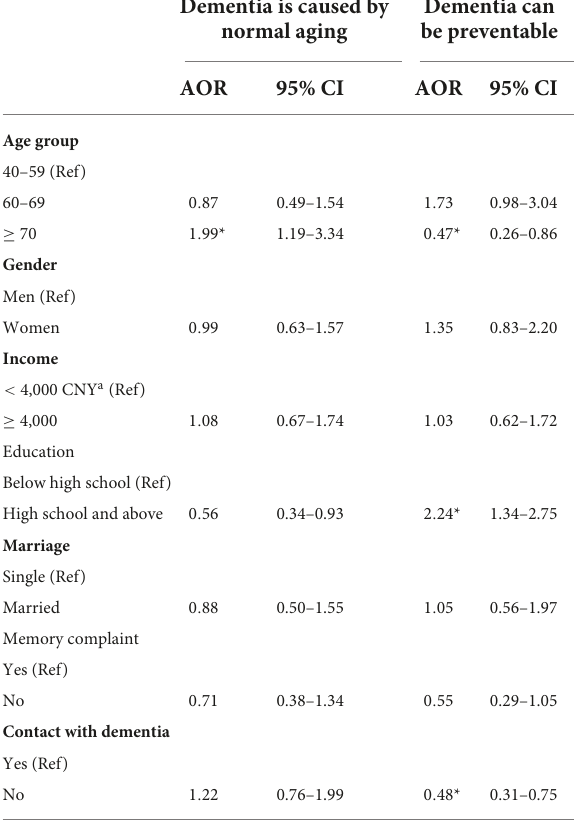
TABLE 2 Socio-demographic factors associated with dementia prevention